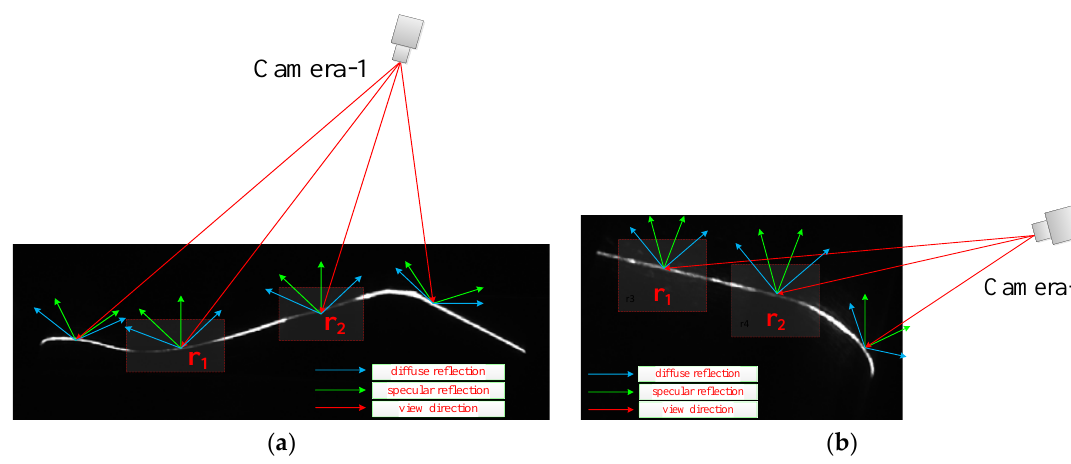
Figure 4. Laser brightness perception of stripe images captured by outer and inner cameras. ( a ) Laser brightness perception of the image from the outer camera; ( b ) laser brightness perception of the image from the inner camera.